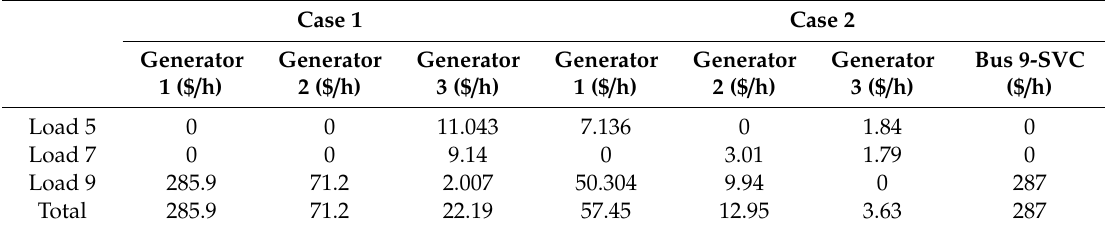
Table 4. Reactive power generation price allocation of the